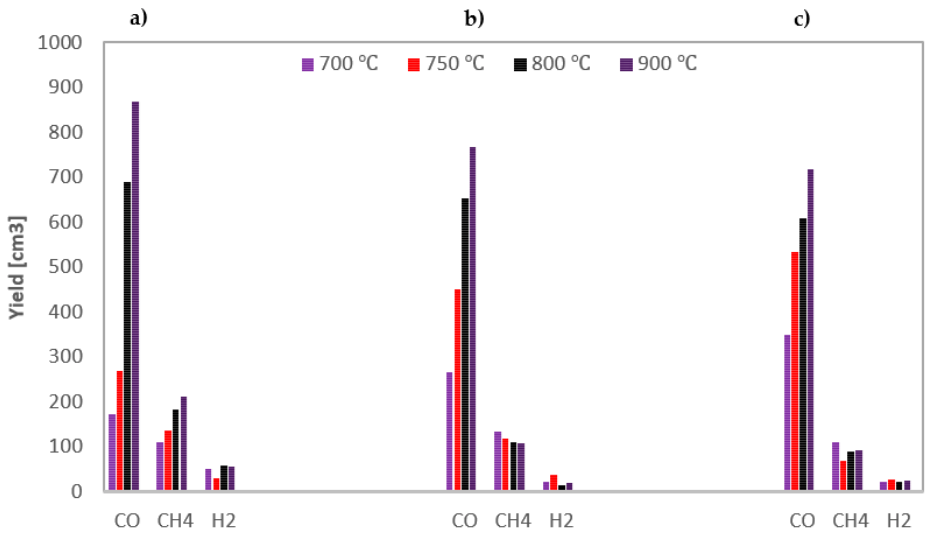
Figure 8. Yields of gas components formed during CO 2 gasification of RDF at various temperatures and under: ( a ) 0.5 MPa; ( b ) 1 MPa; ( c ) 1.5 MPa.